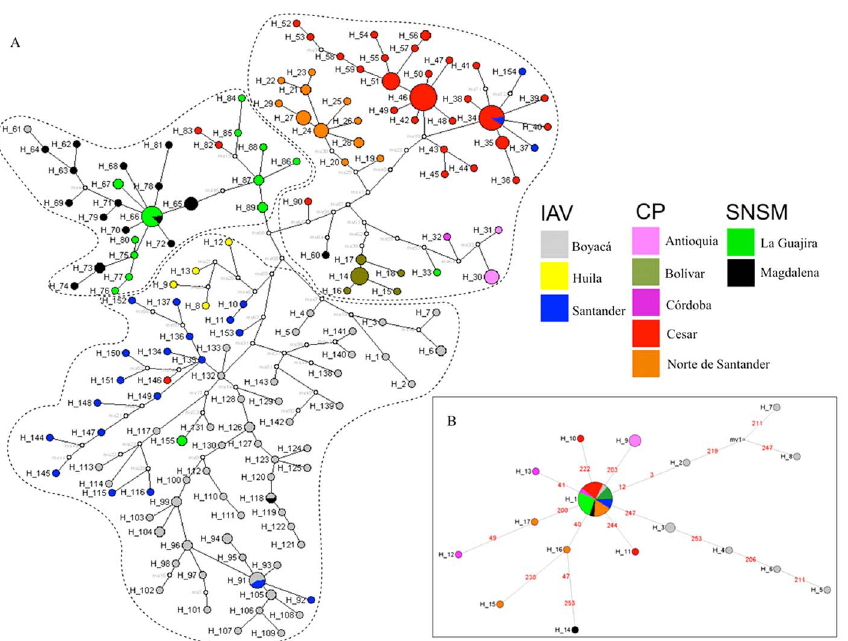
Figure 2. Median-joining haplotype network of the ND4 gene and partial ITS-2 rDNA of T.dimidiata in Colombia. A) ND4 and B) ITS-2 haplotypes found in the study (Tables S3 and S2, respectively) were included in a network analysis according to the eco-geographical region of origin (Table 1). Haplotype frequency is represented by the size of each node and white nodes represent hypothetical haplotypes (or median vectors). Sampled sites were assigned different colors as coded in the legend.